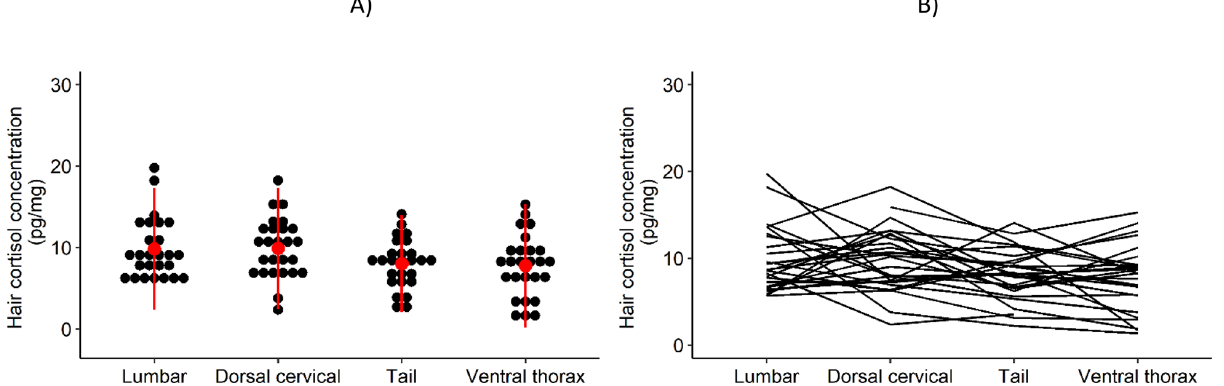
Figure 2. Hair cortisol concentration by body region. ( A ) Mean ± 2 standard deviations (in red) of hair cortisol in paired samples from 27 wolves with 4 body regions analyzed per individual. ( B ) Variation of HCC between body regions of individual